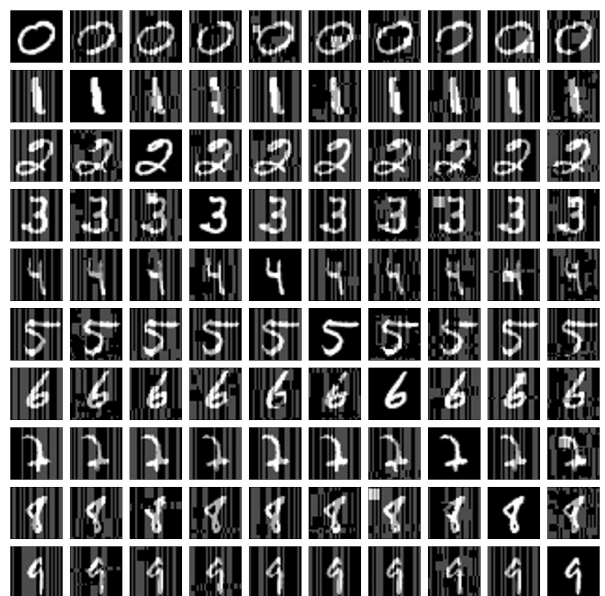
Figure 5. Adversarial examples generated by QuEry Attack on MNIST, with (cid:101) = 60/255. An image at row , col = i , i shows the original image for class i . An image at row , col = i , j , i (cid:54) = j shows a targetted attack on class i , with the target being class j .